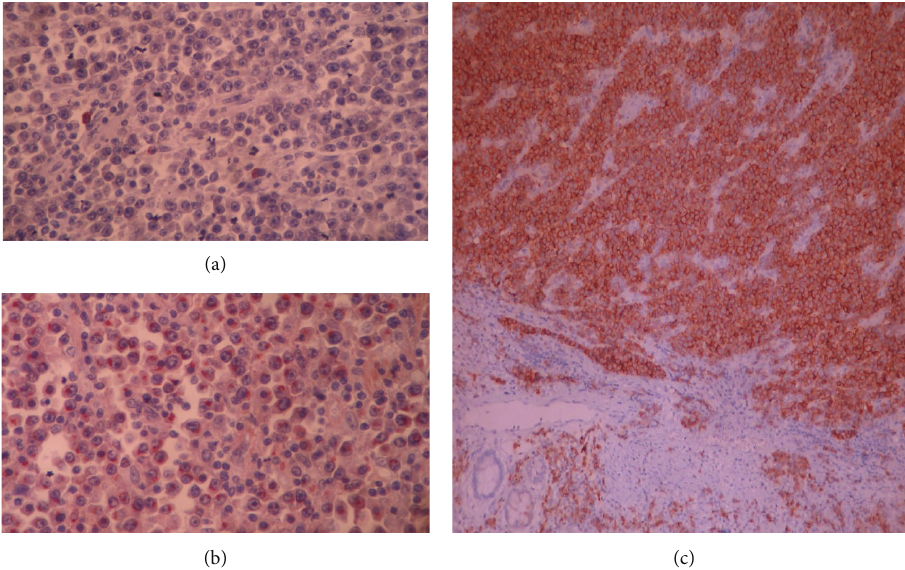
Figure 3: Many of the plasma cells reacted with antibody to Kappa light chain (b) and were not stained with antibody to Lambda light chain except for fewer nonneoplastic plasma cells (a). The atypical plasmocytes expressed surface CD 38 (c).